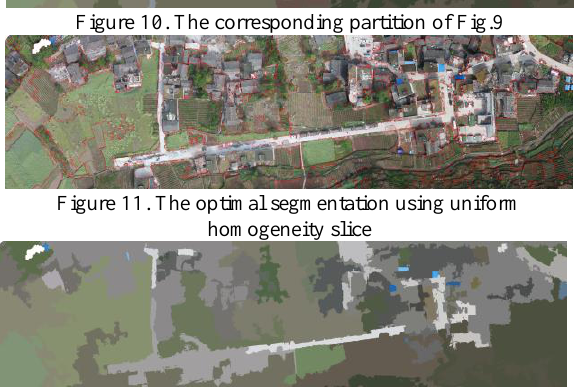
Figure 10. The corresponding partition of Fig.9